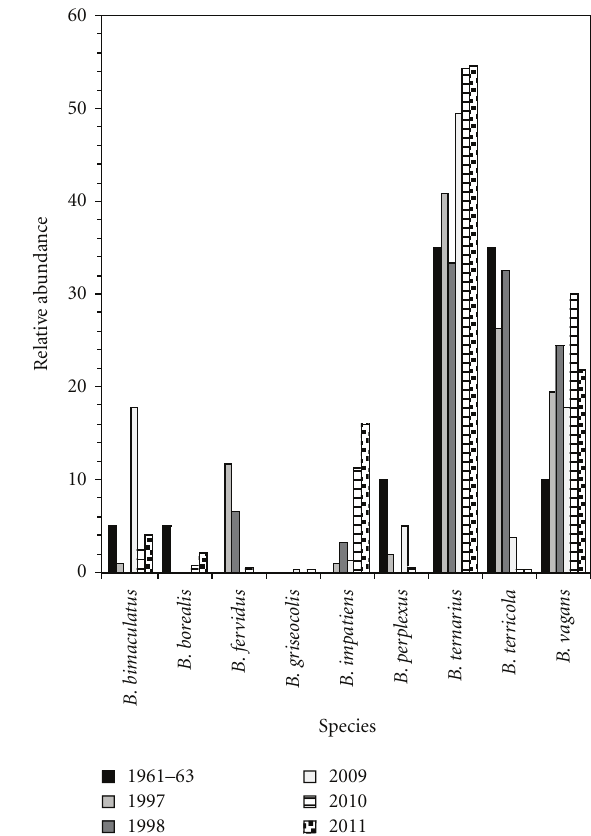
Figure 7: Relative abundances of bumblebee species found in blueberry fields for five years: 1961–63, 1997, 1998, 2009, 2010, and 2011. Psithyrus not shown. B. impatiens from fields with active commercial bumblebee colonies not included. Data for 1961–63 from Boulanger et al.